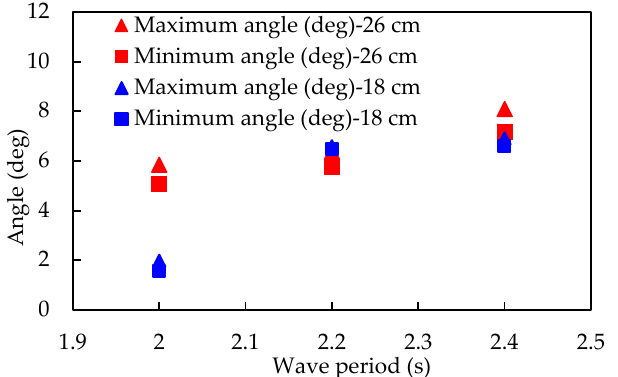
Figure 19. Angle response under different wave periods with wave heights of 18 cm and 26 cm.